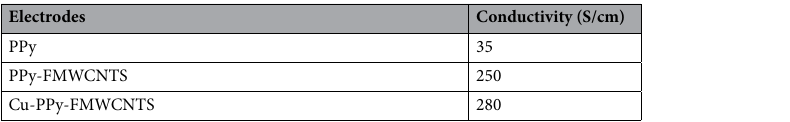
Table 1. Conductivity measurements of PPy, PPy-FMWCNTS and Cu-PPy-FMWCNTS nanocomposites CEs.